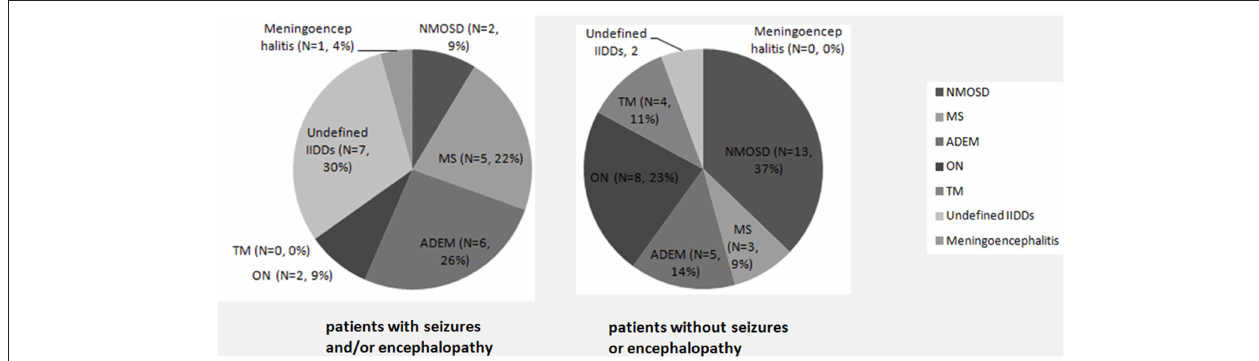
FIGURE 1 | Initial clinical diagnosis in MOG-IgG positive patients with or without seizures and/or encephalopathy. A significantly higher proportion of subjects with seizures and/or encephalopathy were diagnosed as non-specific IIDDs ( P = 0.030), while NMOSD were commonly diagnosed among subjects without seizures or encephalopathy ( P = 0.035).